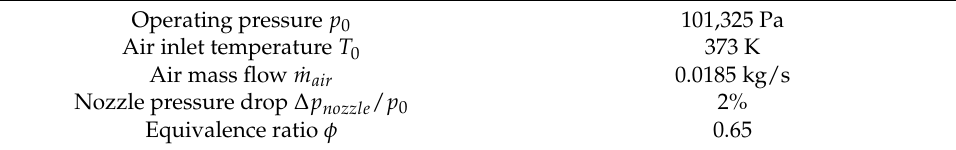
Table 1. Lifted flame experiment operating